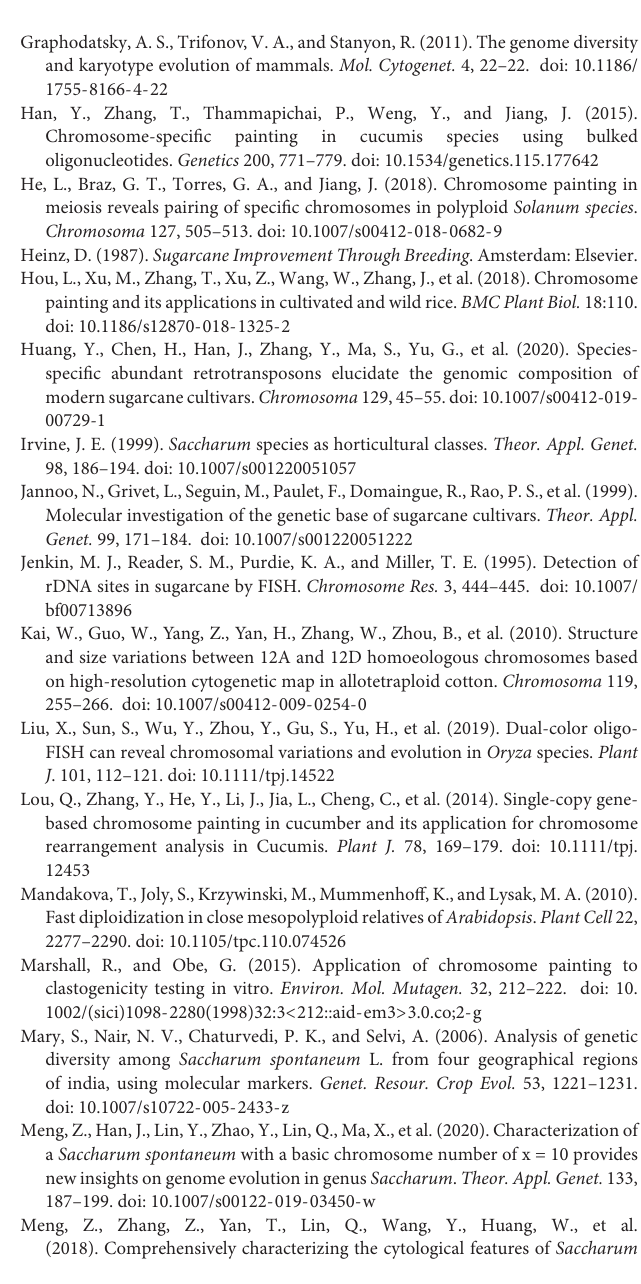
Supplementary Figure 3 | FISH mapping using chromosome-specific probes in S. spontaneum Sichuan79-I-1. Probes specific to chromosomes 1 (Ss1), 3 (Ss3), 4 (Ss4), and 8 (Ss8.1) were hybridized in Sichuan79-I-1. Eleven signal copies from probes of Ss1 (A) , Ss3 (B) , and Ss4 (C) , and ten copies from Ss8.1 (D) were observed. The probes used in FISH is indicated in the corresponding panel. Scale bars, 10 µ m. Supplementary Figure 4 | FISH mapping using chromosome-specific probes in S. officinarum Badila. Probes specific to chromosomes 1 (A) , 3–5 (B–D) , and 8–10 (E–G) were hybridized in Badila. Eight signal copies for each probe were observed. The probe used in FISH is indicated in the corresponding panel. Scale bars, 10 µ m. Supplementary Data Sheet 1 | The oligo sequence for CP2